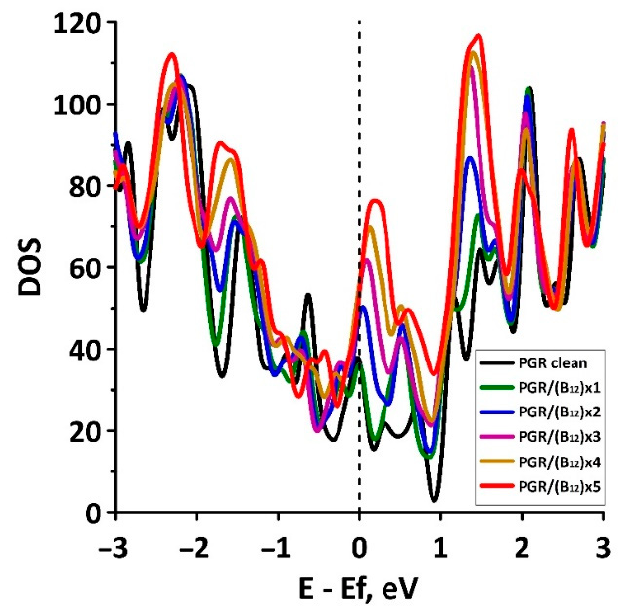
Figure 2. Density of states (DOS) curves of the considered model of electrode material.